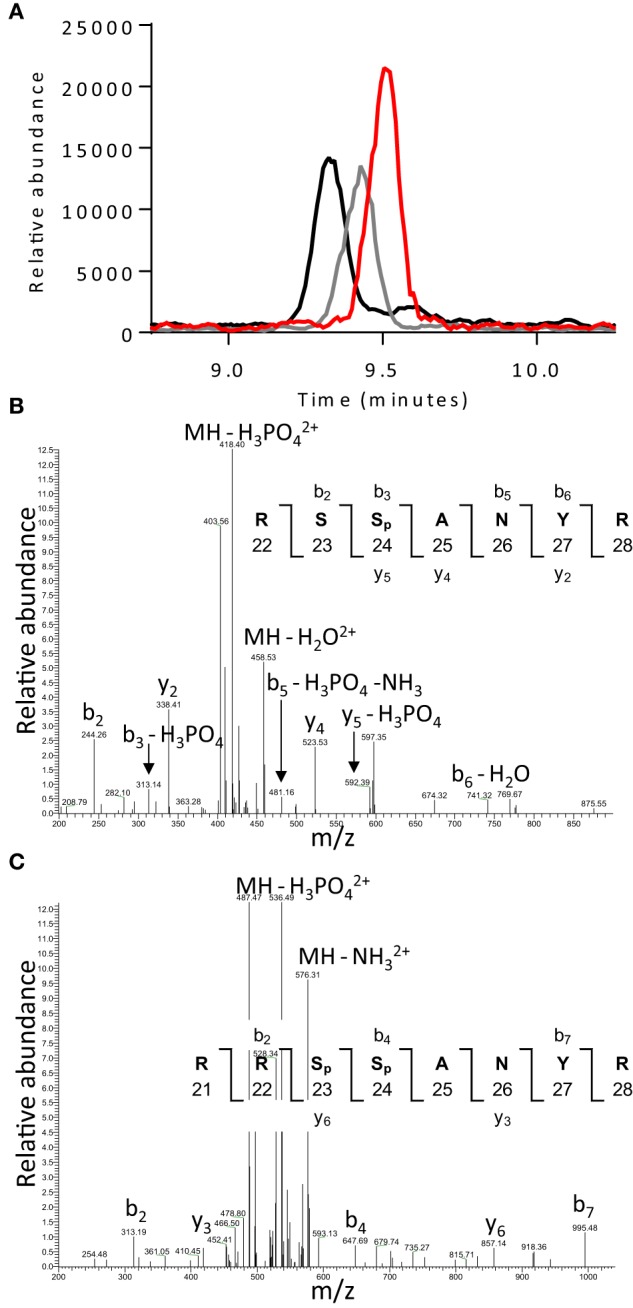
LC elution profiles and data dependent MS2 spectra for troponin I peptides. (A) Representative LC elution profiles for the non-phosphorylated 23SSANYR28 (red), mono-phosphorylated 22RSSpANYR28 (gray), and bis-phosphorylated 21RRSpSpANYR28 (black) peptides. Data dependent MS2 spectra for the (B) mono-phosphorylated 22RSSpANYR28 and (C) bis-phosphorylated 21RRSpSpANYR28 peptides showing fragment ions used for peptide identification and localization of phosphate.